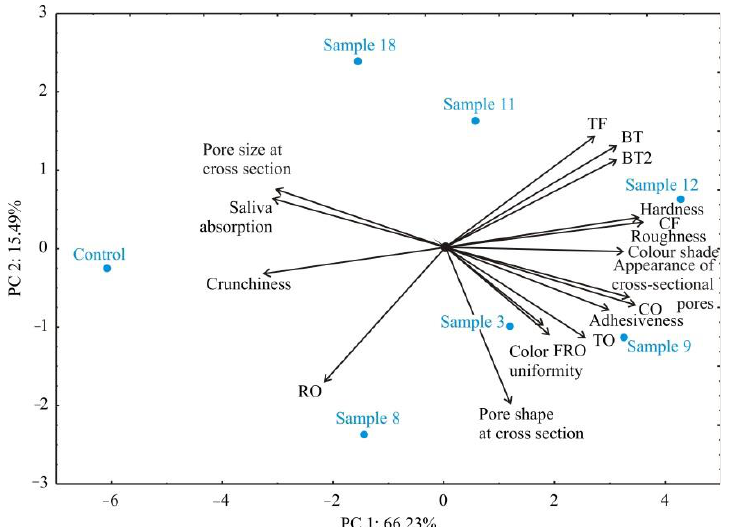
Figure 3. PCA biplot diagram for analyzed samples and observed sensory properties (TO — Total odor intensity, RO — The intensity of the odor on rice, FRO — Odor intensity on fried rice, CO — The intensity of the odor on chicory, BT — Bitterness, BT2 — Bitter taste after 2 min, TF — Total flavor intensity, CF — Flavor intensity on chicory).